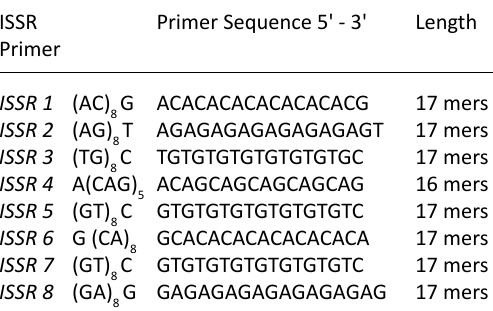
Table 1. Details of ISSR primer and sequence